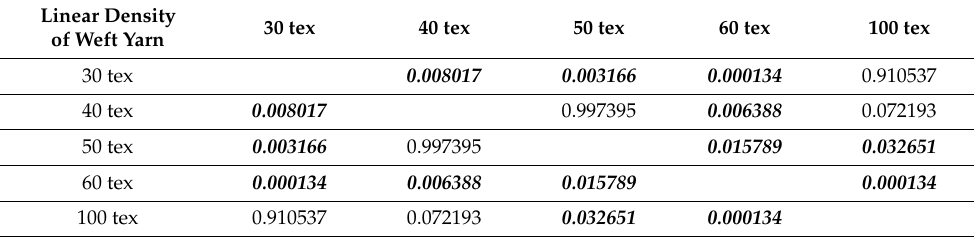
Table 7. The results of the Tukey’s test for the TAR.